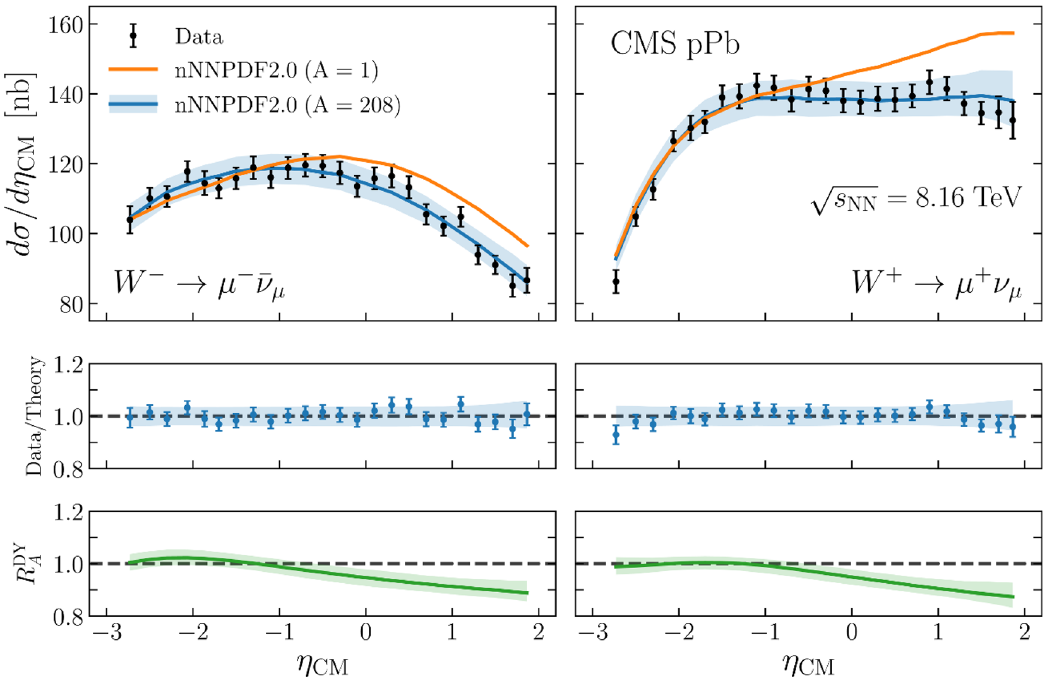
Figure 8 . Same as (cid:12)gure 6 now for the CMS muon rapidity distributions in W (cid:0) and W + production p at s = 8 : 16 TeV.